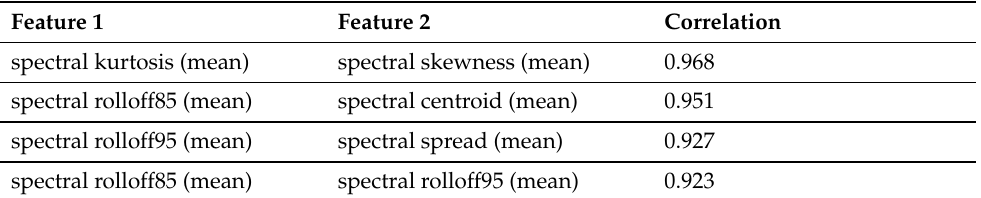
Table 5. Highly correlated features in the IADSE